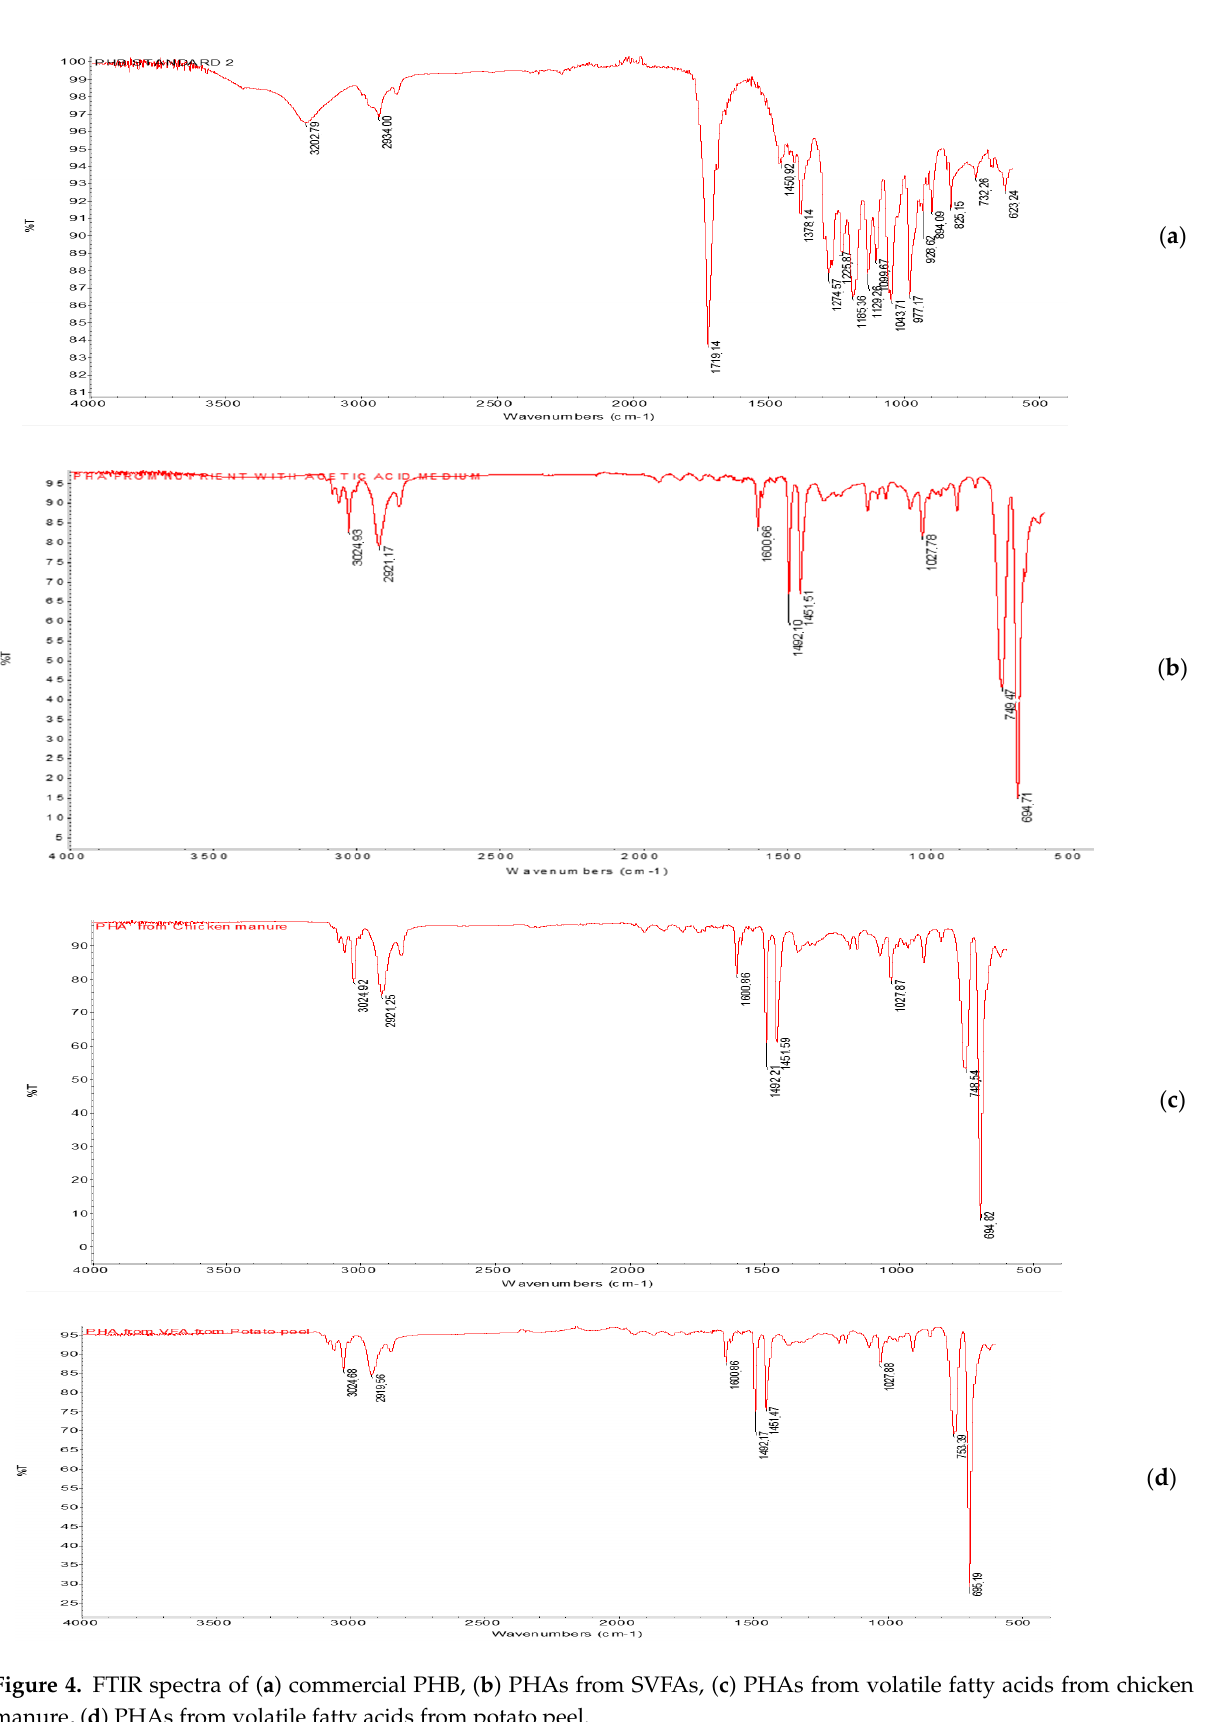
Figure 4. FTIR spectra of ( a ) commercial PHB, ( b ) PHAs from SVFAs, ( c ) PHAs from volatile fatty acids from chicken manure, ( d ) PHAs from volatile fatty acids from potato peel.